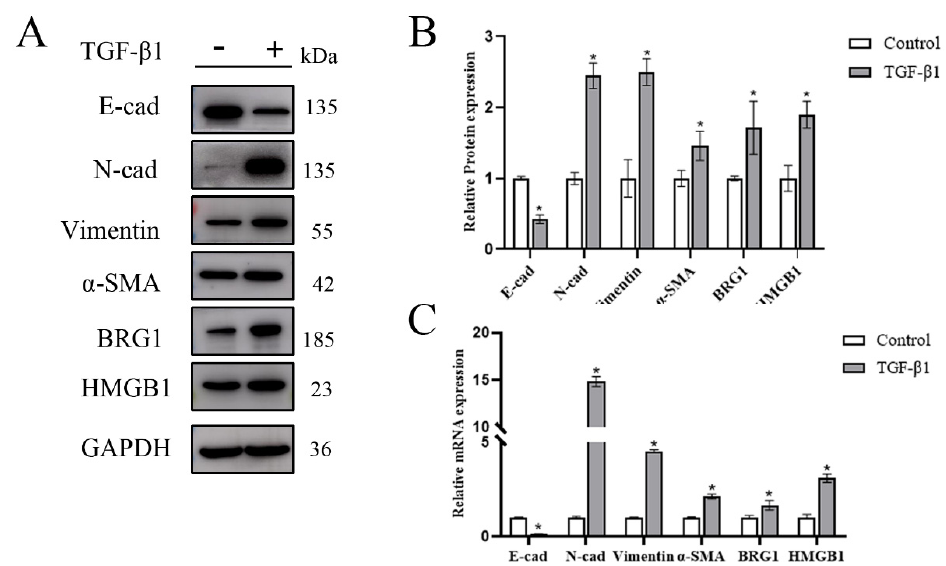
Figure 1. In the EMT model stimulated by TGF- β 1, the expression of HMGB1 and BRG1 increased. ( A , C ) After 48 h of culture in the medium containing 5 ng/mL TGF- β 1, E-cad, N-cad, Vimentin, SMA, HMGB1, BRG1, and GAPDH were detected by Western blotting and RT-qPCR. ( B ) Quantification. GAPDH was used as an internal control. Shown are the averages of three independent experiments. *: p < 0.05 compared with the control cells.